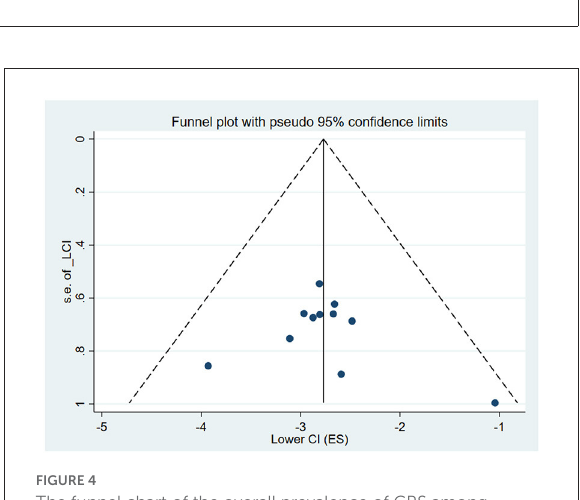
FIGURE4 The funnel chart of the overall prevalence of CRS among